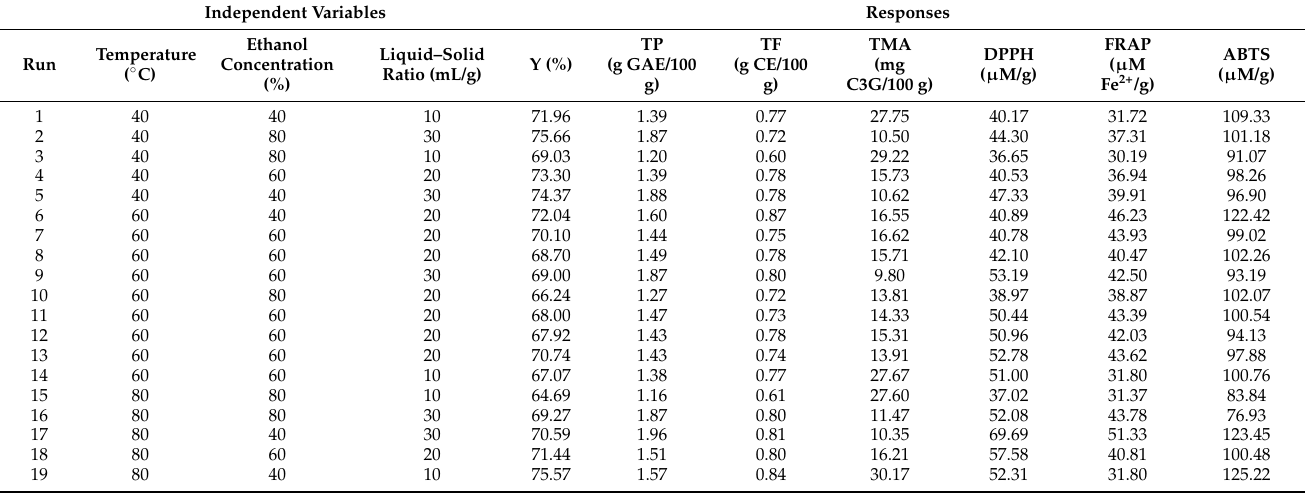
Table 2. Experimental design (face-centered central composite) with coded and natural levels of the parameters of UAE and experimentally observed values of investigated